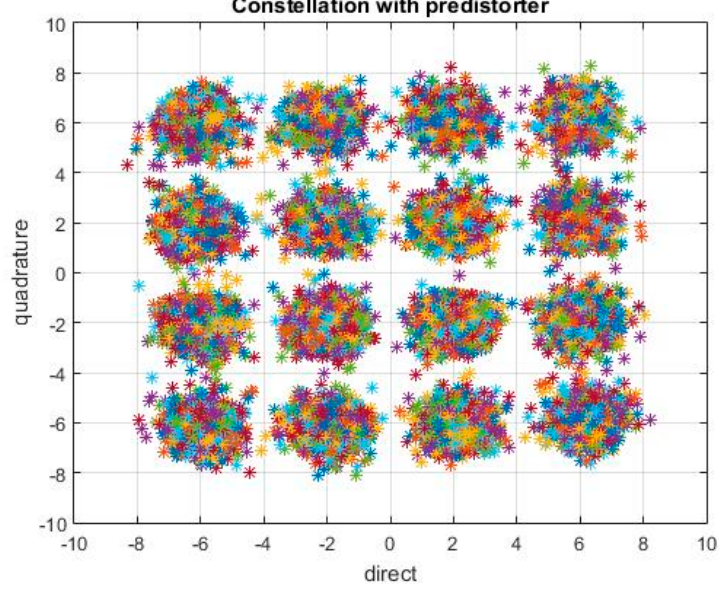
Figure 13. GFDM constellation with predistorter.